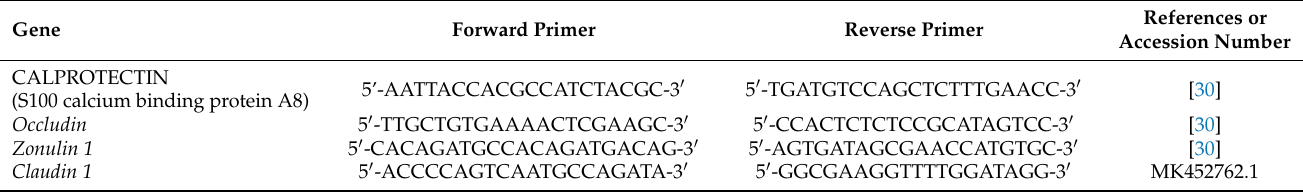
Table 5. Primers for tight junction (OCL, ZON and CLAU) and Calprotectin (CAL). Forward